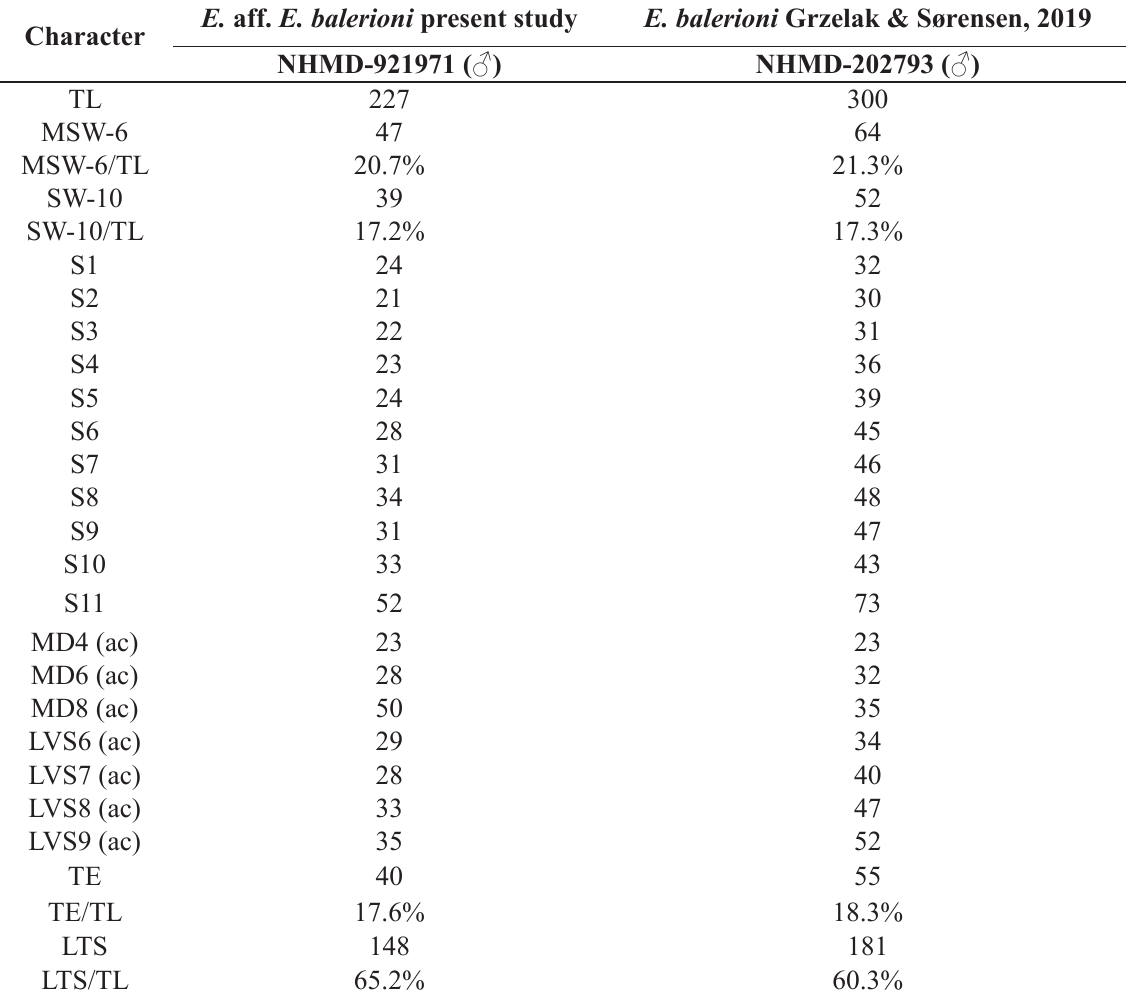
Table 22. Measurements from light microscopy of Echinoderes sp. aff. E. balerioni (in µm) from the Hikurangi Margin with a comparison of measurements for E. balerioni from its type